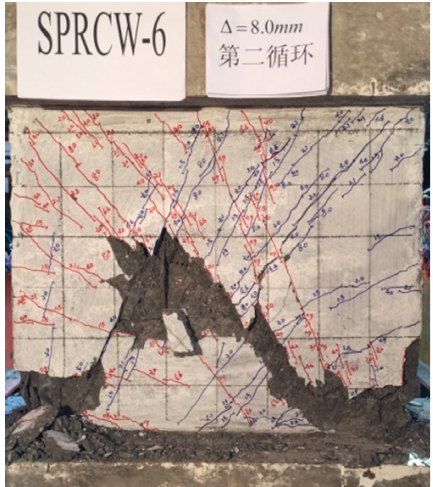
Figure 8: Failure mode of